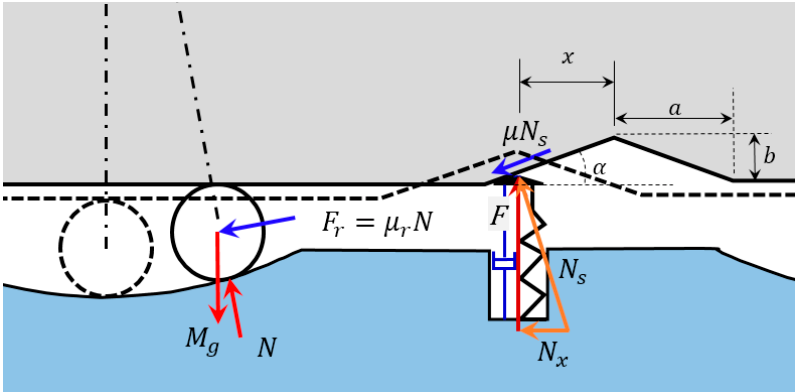
Figure 2. Free body diagram of the isolator.